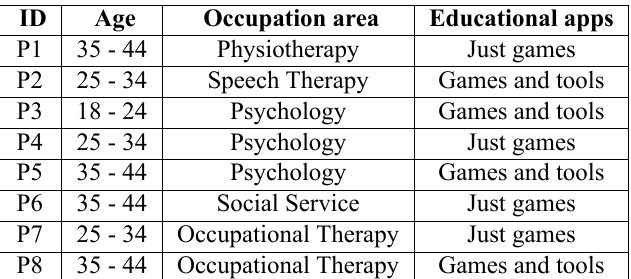
Table 4. Experts